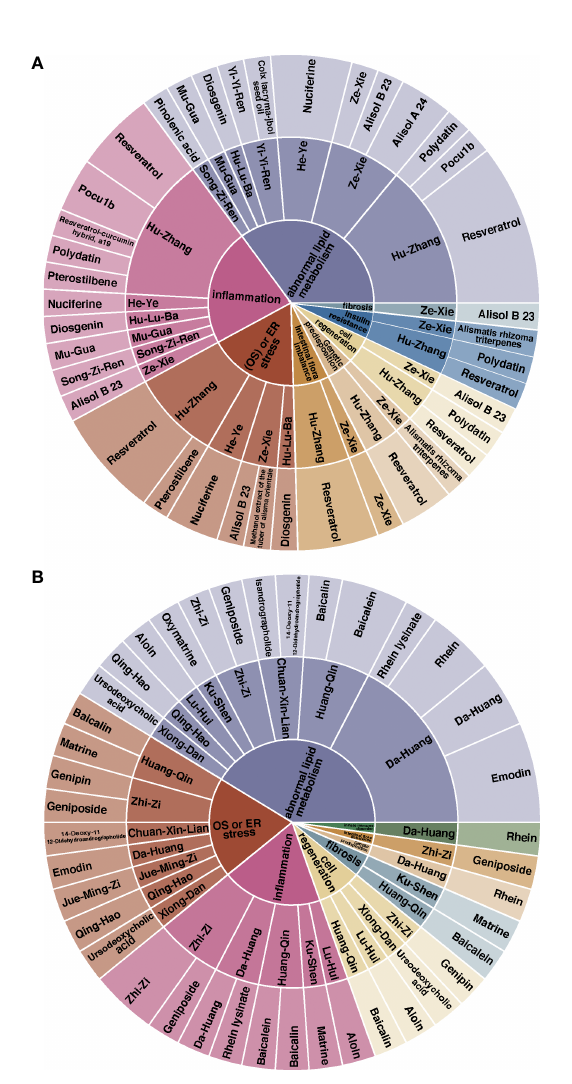
FIGURE 6 The relationship between (A) anti-dampness herbs and their active components, (B) clearing-heat herbs and their active components and the current pathological factors of NAFLD. The inner part is the pathological mechanism of NAFLD, the middle represents the corresponding herbs, and the outside is their active components. The colors represent the different molecular mechanisms of pathology and the size represents the proportion of the current study. The names of the individual herbs are given in Chinese and the corresponding English names are detailed in Tables 2,